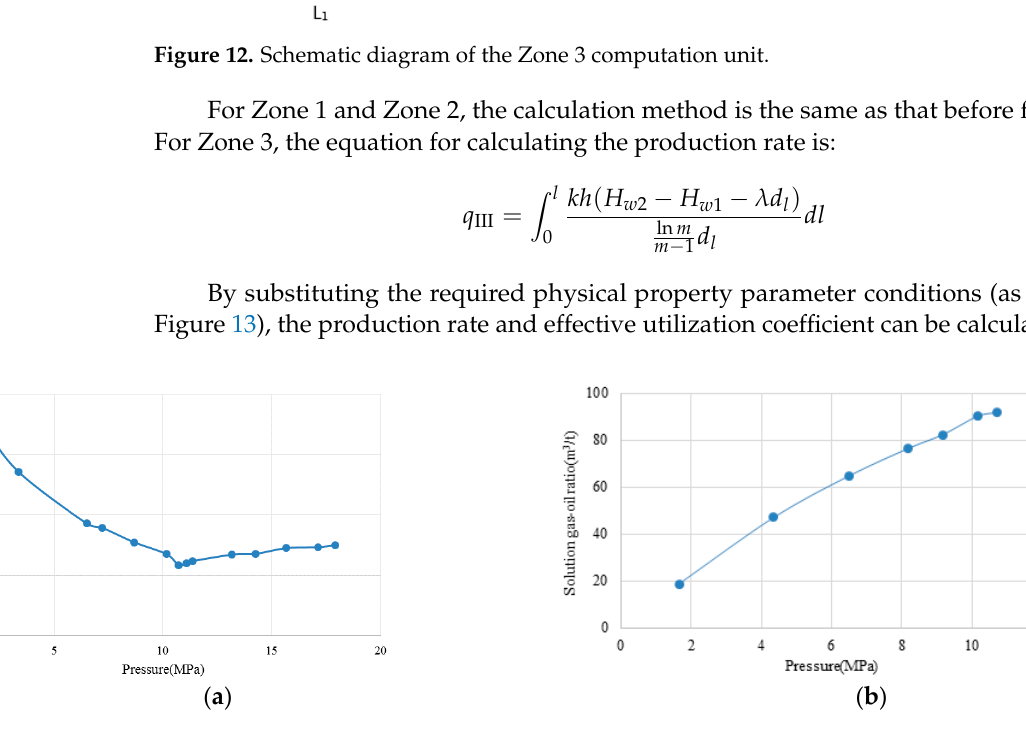
ratio Figure 13. Some of the required physical property parameter conditions: ( a ) crude oil viscosity-pressure; ( b ) solution gas–